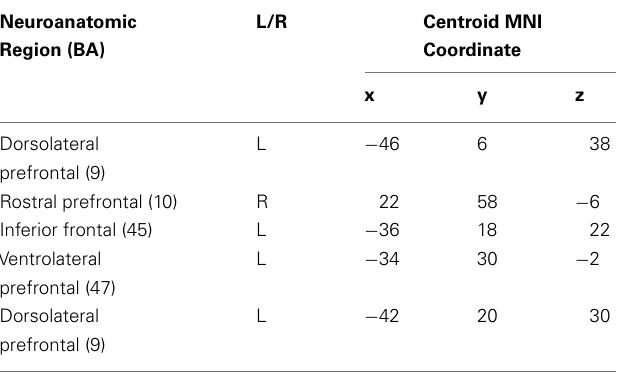
Table 4 | Regions of overlap between fMRI activation in healthy young adults and reduced gray matter density in bvFTD patients relative to healthy